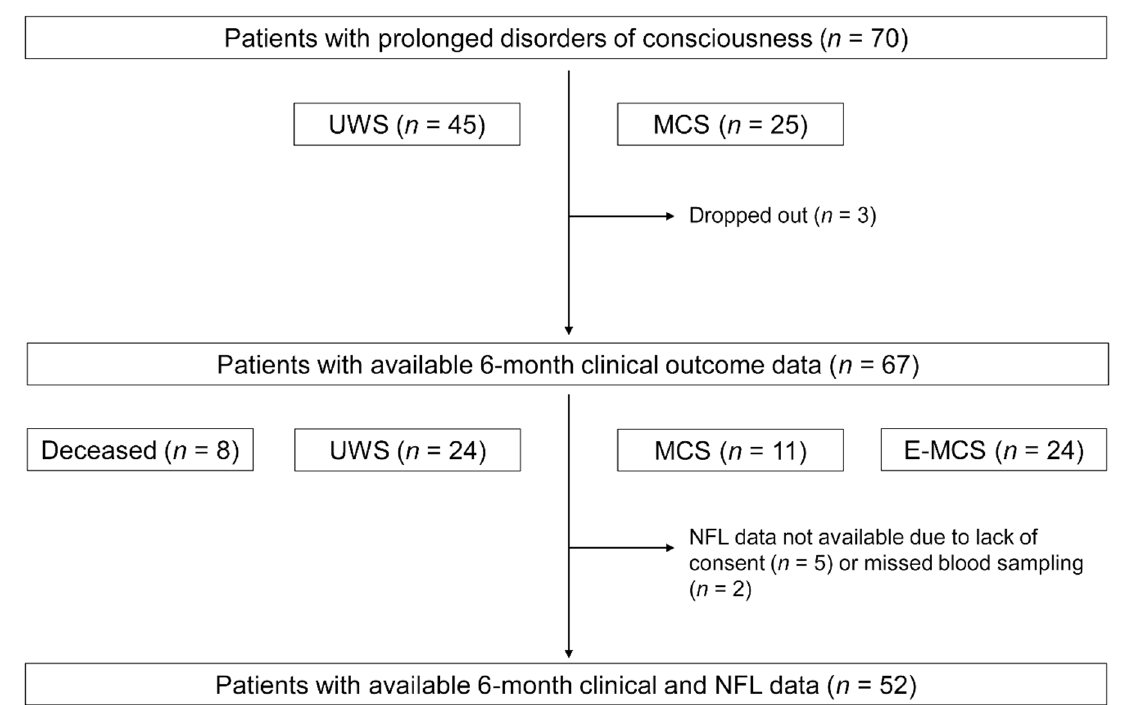
Figure 1. Study flow and patients’ levels of consciousness at 1–3 and 6 months post-injury. UWS, unresponsive wakefulness syndrome; MCS, minimally conscious state; E-MCS, emergence from a minimally conscious state; NFL, neurofilament light chain.